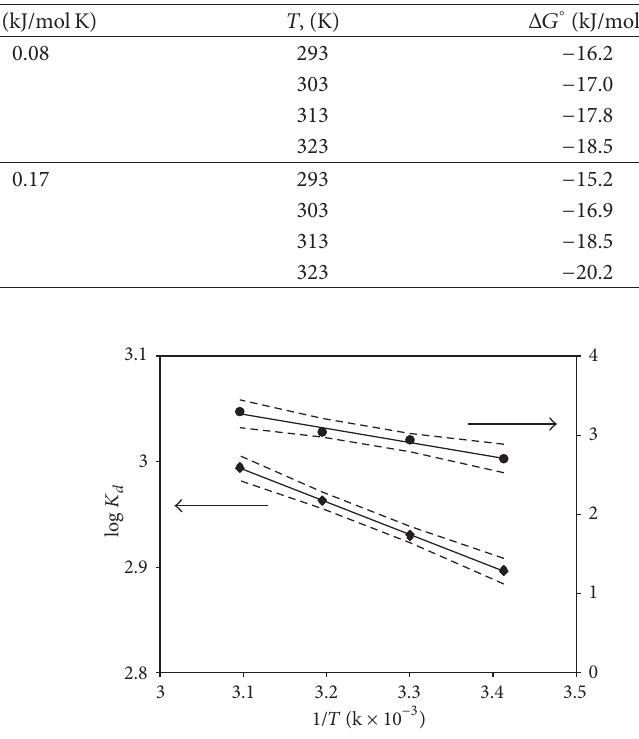
T 4: Changes of enthalpy, entropy, and Gibbs-free energy for the adsorption of lanthanum and europium on hydroxyapatite.